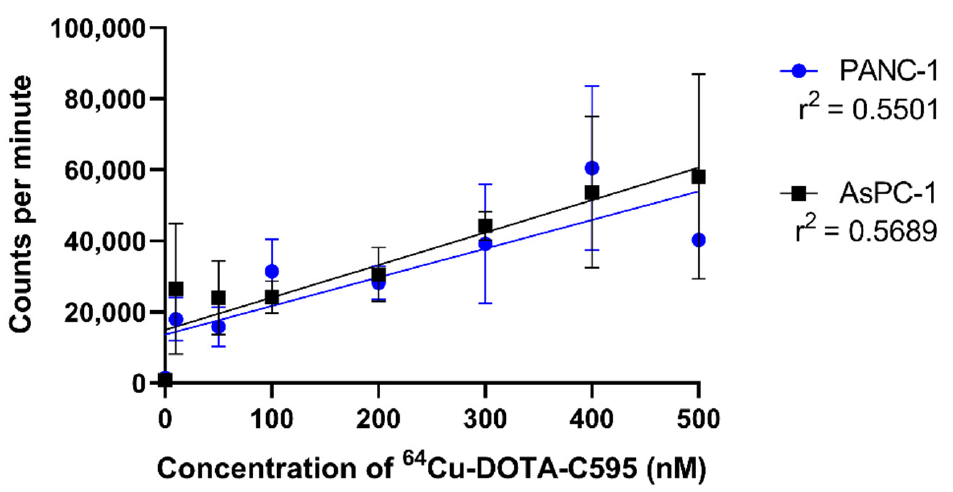
Figure 8. Blocking experiment demonstrating the binding of 64 Cu-DOTA-C595 to PANC-1 and AsPC-1 cells following C595-blocking. Data presented as mean ± standard deviation.